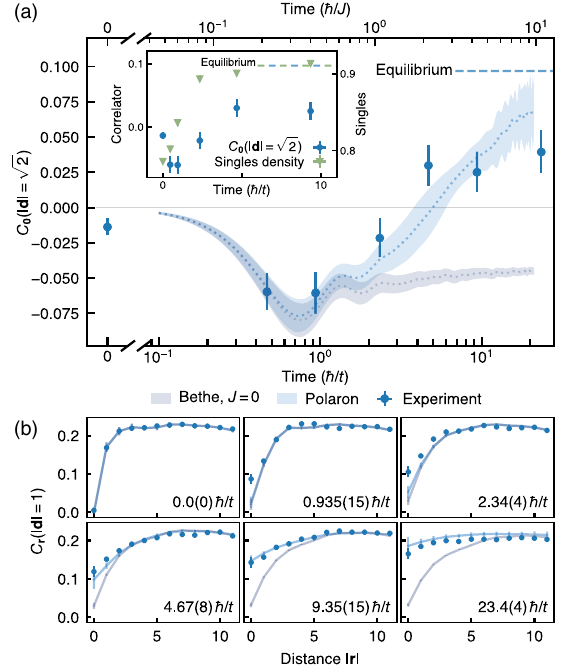
FIG. 5. Comparison with a polaron model. (a) Sign-corrected spin correlations between the initial hole location and its diagonal ffiffiffi p 2 Þ ] as a function of time. The short-time neighbors [ C 0 ðj d j ¼ dynamics are captured by a Bethe-lattice model considering only charge motion (purple-gray band), while spin exchange must be taken explicitly into account (here, as a polaron model, blue band) to qualitatively describe the long-time relaxation of the correla- tions towards their equilibrium values (blue dashed line). This correlation relaxation is slower than the density relaxation averaged on a 3 × 3 area around the center (inset). (b) Near- est-neighbor correlations as a function of distance to the center C ðj d j ¼ 1 Þ . The slow spreading of the depleted correlations r towards the system edges is best captured by the polaron model (blue) as opposed to the Bethe-lattice model (purple-gray). Neither model quantitatively captures the short-time dynamics at the center ( j r j ¼ 0